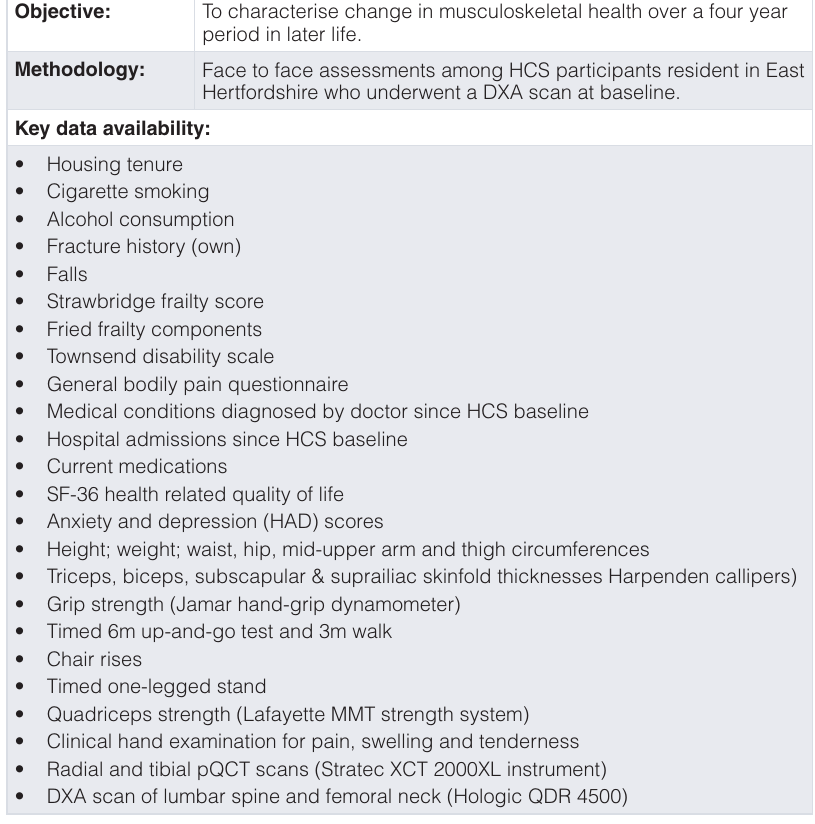
Table 4. Hertfordshire Cohort Study clinical outcomes questionnaire. Objective: To ascertain information on medical diagnoses and clinical events experienced by cohort members since baseline. Cohort wide postal